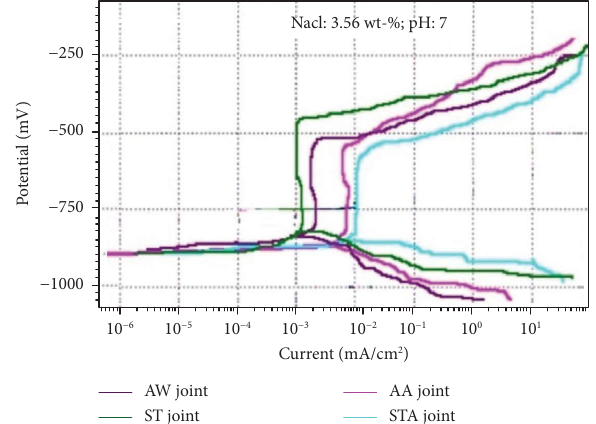
Figure 12: Tafel plot of welded joints in 3.56wt.% NaCl solution having a pH of 7.